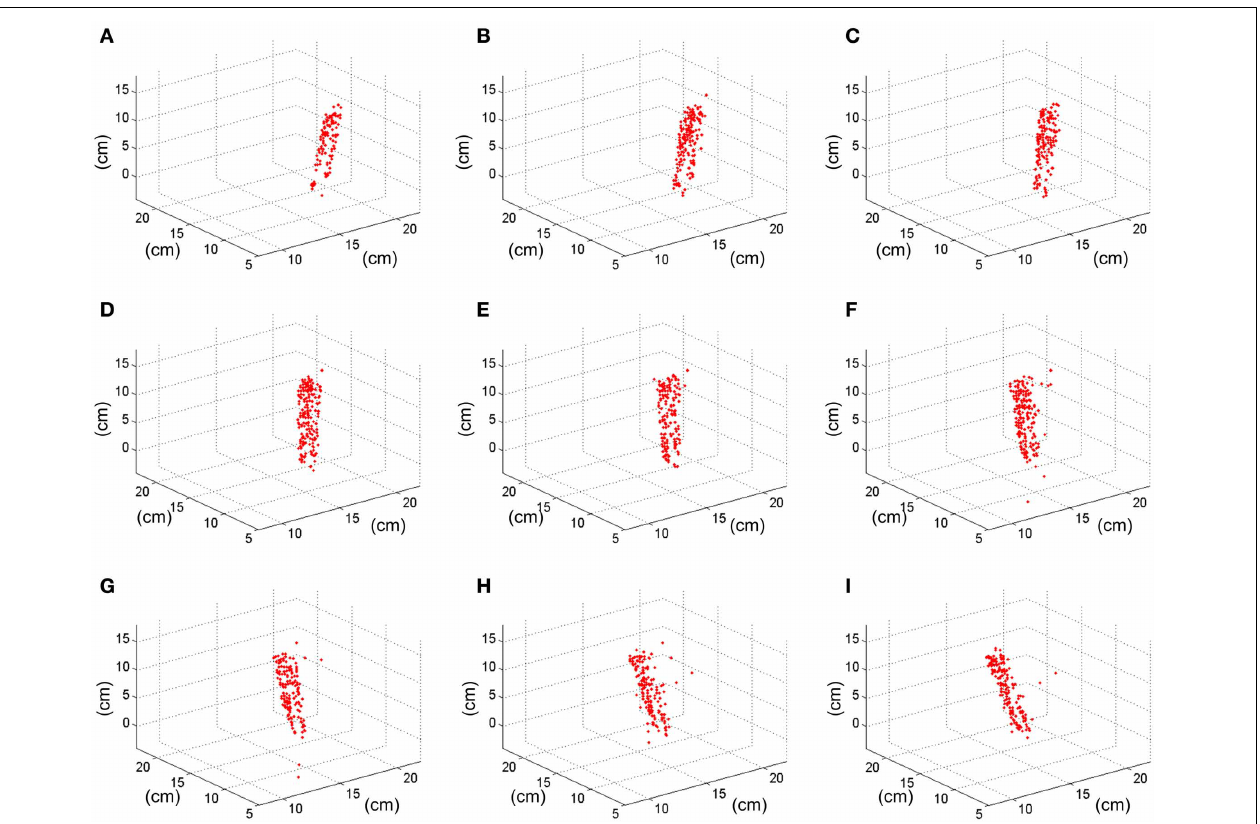
FIGURE 17 | Result of the 3D reconstruction of the swinging pen recording. Each plot (from A – I ) corresponds to a 50 ms-frame representation of the 3D coordinates of the matched